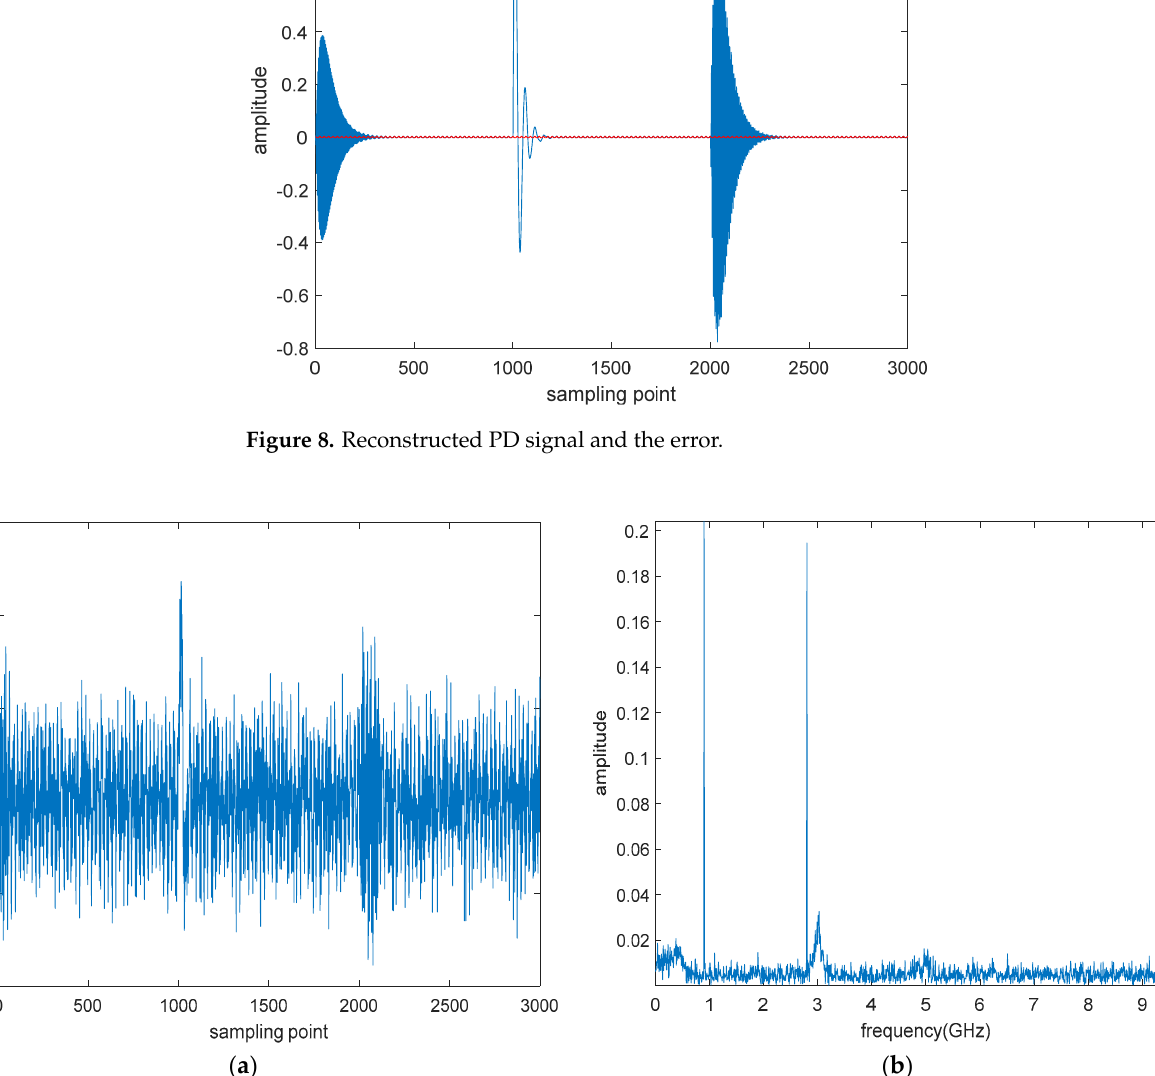
Figure 8. Reconstructed PD signal and the error.